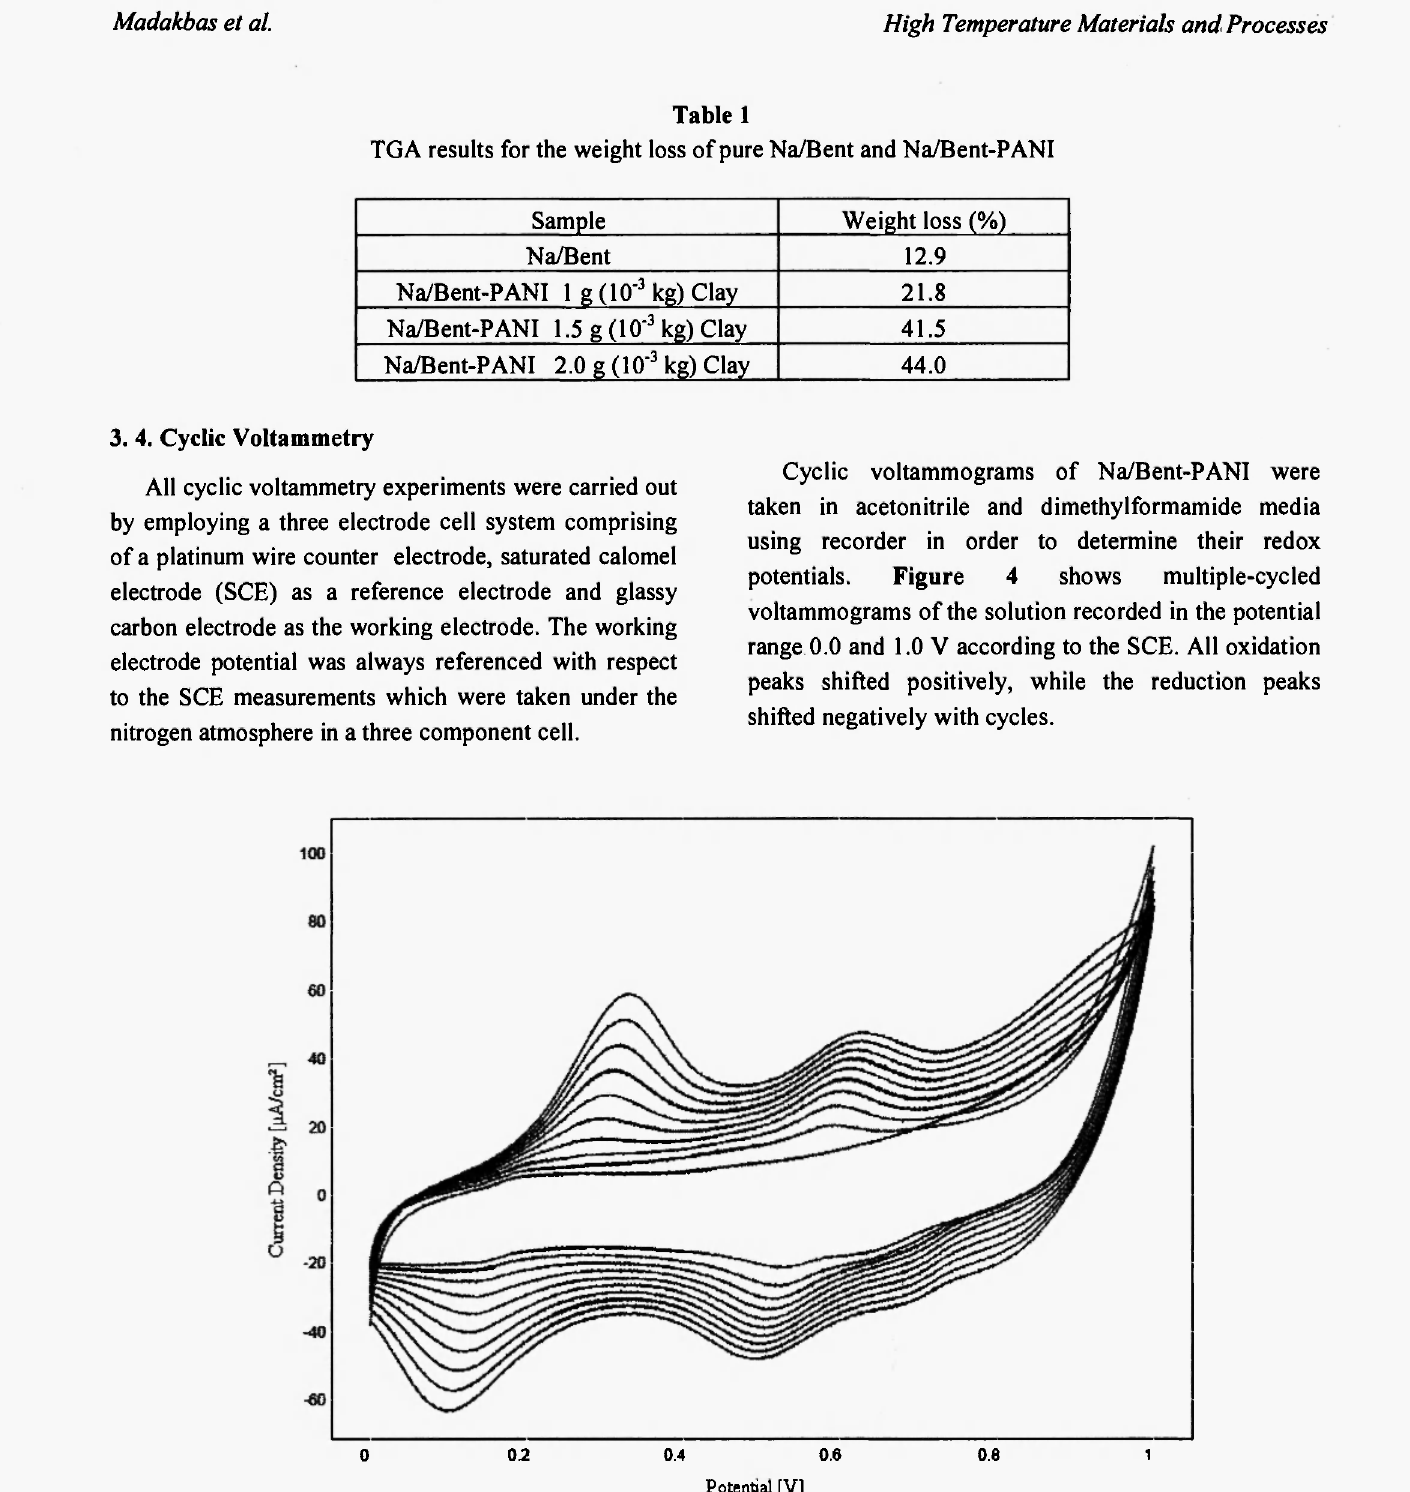
Fig. 4: Cyclic voltammogram of Na/Bent-PANI in acetonitrile medium 10 cyclic. Scan rate: 100mV/s. Current density: μΑ/cm^ 10' 2 A/m 2 .